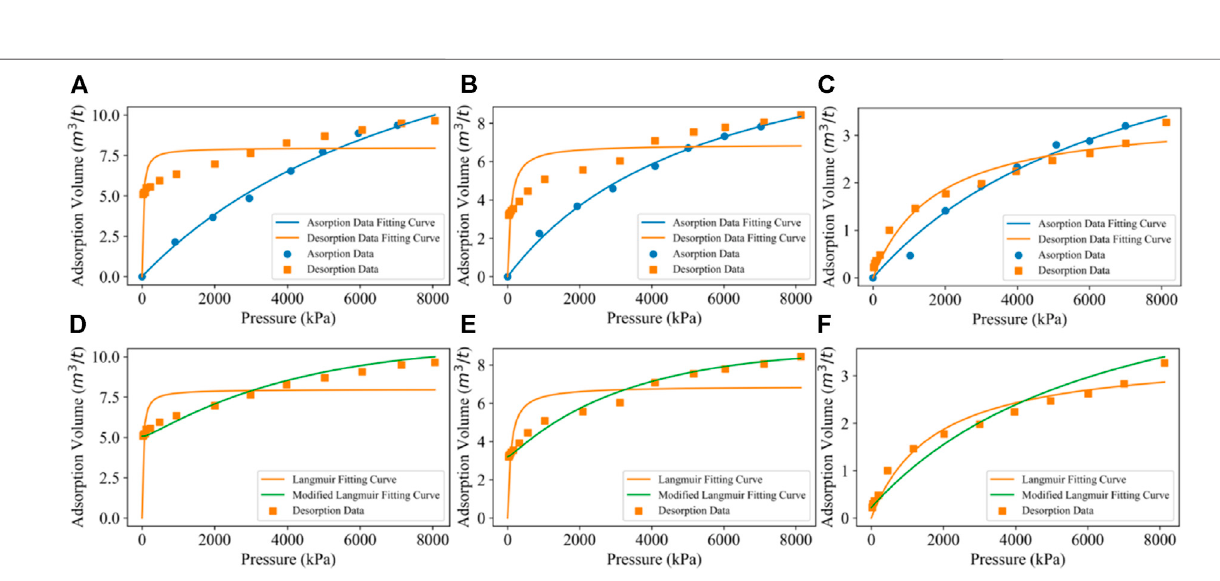
Frontiers in Earth Science |